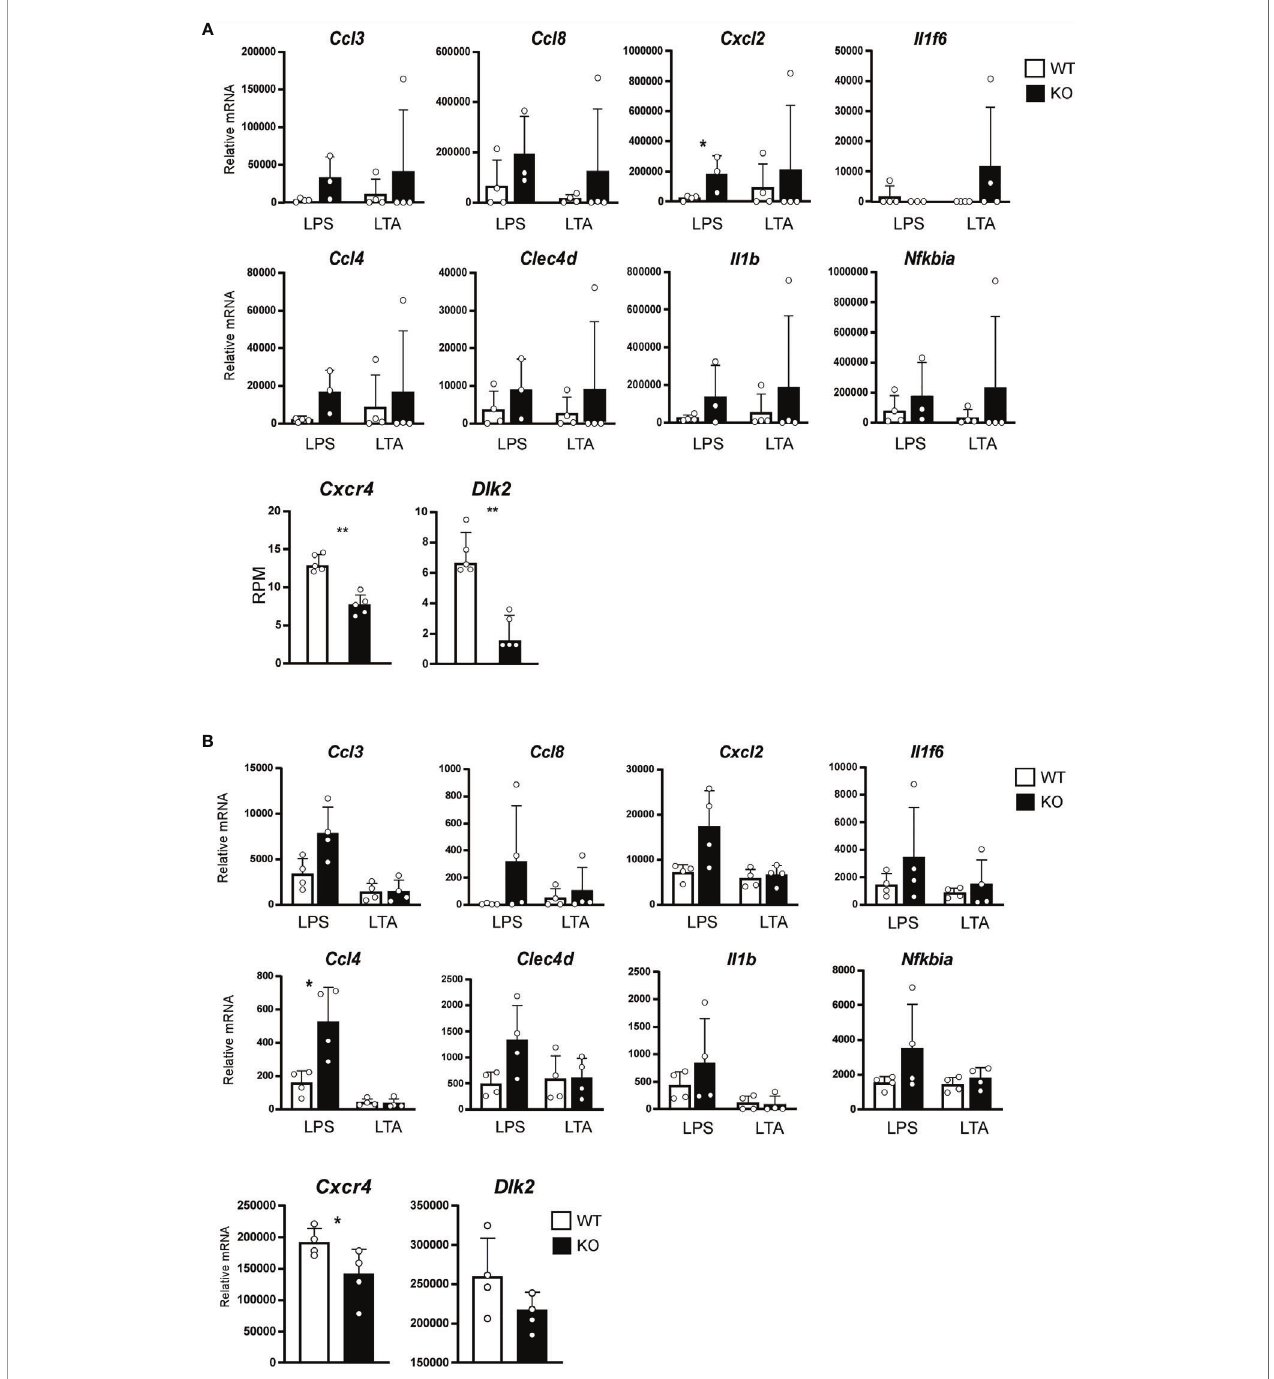
FIGURE 4 | Expression of Toll-like receptor (TLR) target genes affected by the STAT3 signaling. (A) Ears of 6-week-old WT (white bars) or B6 background Stat3 f/f K5-cre (KO, black bars) mice were treated with 10 mg of lipopolysaccharide (LPS) or lipoteichoic acid (LTA) continuously once a day for 10 days. Relative expression of mRNA of indicated genes that were regulated by TLR signaling was determined by a RT-qPCR (n=4, top and middle line). Total RNA were isolated from skin of 2- week-old B6 background Stat3 f/f (WT, white bars) or Stat3 f/f K5-cre (KO, black bars) mice, and relative mRNA expression of Cxcr4 and Dlk2 genes was determined by a RNA-seq (n=5, bottom line). (B) Keratinocytes isolated from neonatal B6 background Stat3 f/f (WT, white bars) or Stat3 f/f K5-cre (KO, black bars) mice were treated with 10 µg/ml of LPS or LTA for 24 hr. Relative expression of mRNA of indicated genes that were regulated by TLR signaling was determined by a RT-qPCR (n=4, top and middle line). Relative expression of mRNA of Cxcr4 and Dlk2 genes in keratinocytes isolated from neonatal B6 background Stat3 f/f (WT, white bars) or Stat3 f/f K5-cre (KO, black bars) mice was determined by a RT-q-PCR (n=4, bottom line). *p<0.05,